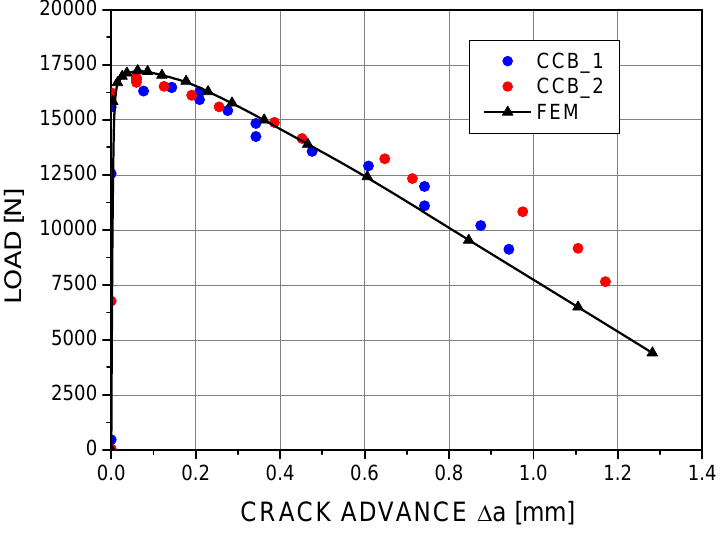
Figure 9: Comparison of predicted and measured applied load vs crack advance .